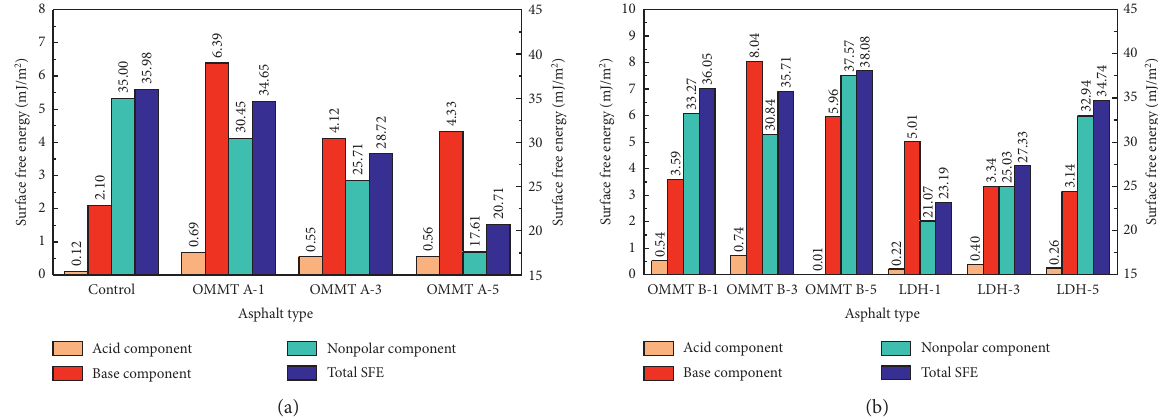
Figure 5: SFE components of the binders: (a) control and OMMT-A-modified asphalts; (b) OMMT-B- and LDH-modified